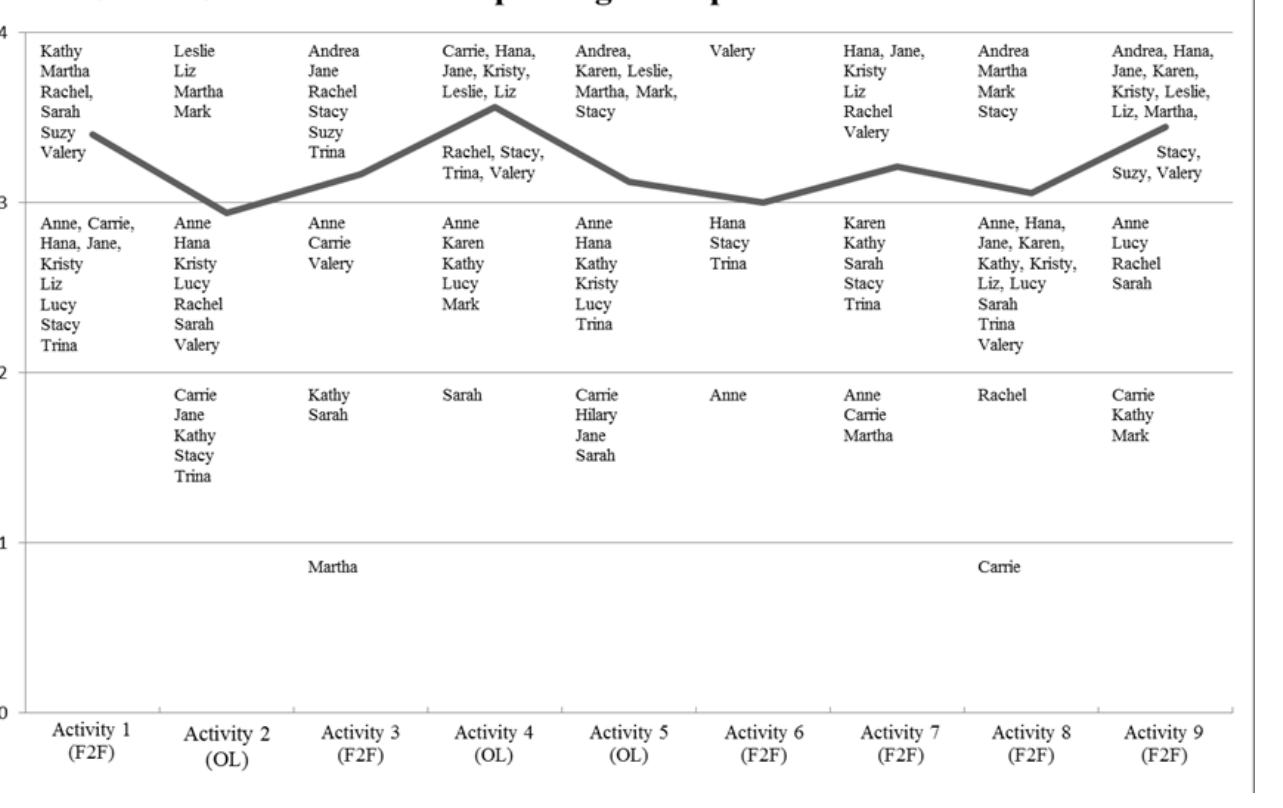
Figure 2 . Comparison of Individual DropThought Scores to Class Average Over